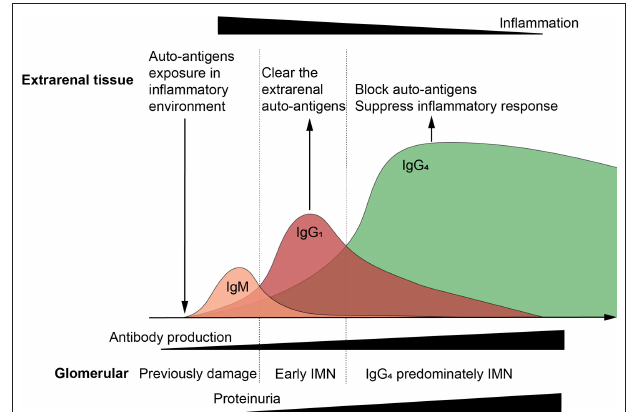
FIGURE 3 | Relationship between extrarenal tissue, immune response, and glomerular damage. Auto-antigens exposure in inflammatory environment induce the auto-immune response, and subsequently immunoglobulins (Ig) undergo class switching. IgG1 mediates the most auto-antigen clearance as the primary effector antibody, and IgG4 blocks auto-antigens as the high affinity anti-inflammatory antibody. When pathogens and auto-antigens are effectively eliminated, the extrarenal inflammatory, and immune responses tend to be alleviated. However, large amounts of antibodies are deposited in the glomeruli, especially IgG4, leading to filtration barrier damage and proteinuria. Extrarenal remission and glomerular damage aggravation were observed,